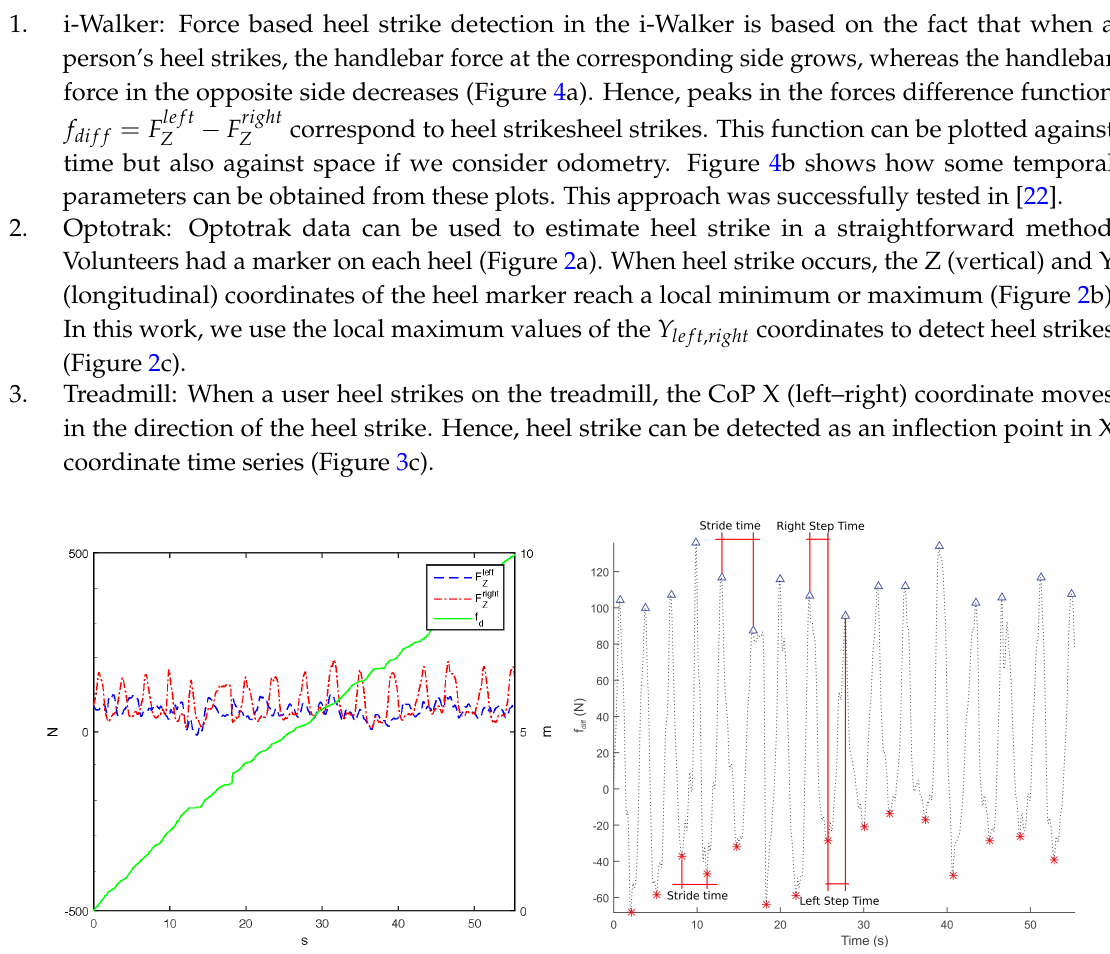
, F right ) and distance traveled Z Z